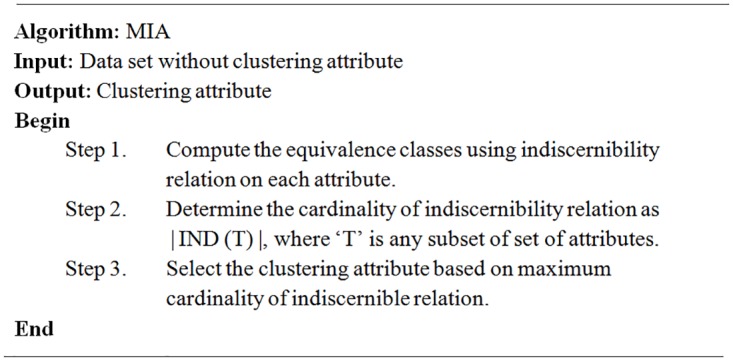
The MIA Algorithm.